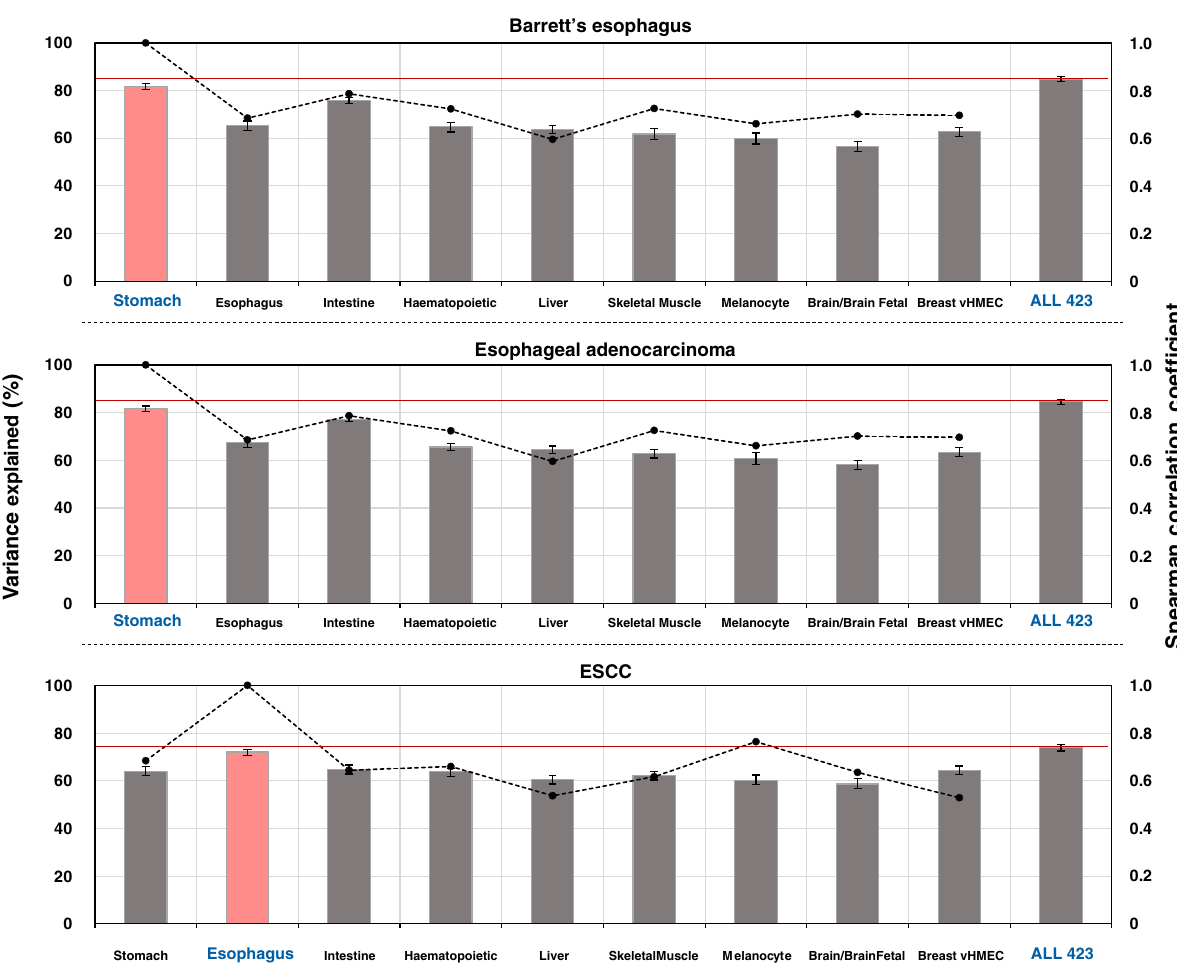
Fig. 4 Regional mutation frequency landscape of esophageal squamous cell carcinoma demonstrates the uniqueness of signi fi cant chromatin features associated with the Barrett ’ s esophagus and esophageal adenocarcinoma genomes. Average variance explained scores for pre- cancerous or matching cancer genomes were separately calculated using the tissue or cell type-based subgroup-classi fi ed chromatin features. The pink panel represents subgroups with the highest variance explained score for each cell type. The red line indicates the variance explained score when using all 423 epigenomic features. Dots represent the Spearman ’ s rank correlations ( r ) of chromatin features between the highest variance explained-scored subgroup and the remaining subgroups. Error bars demonstrate minimum and maximum values derived from 1000 repeated